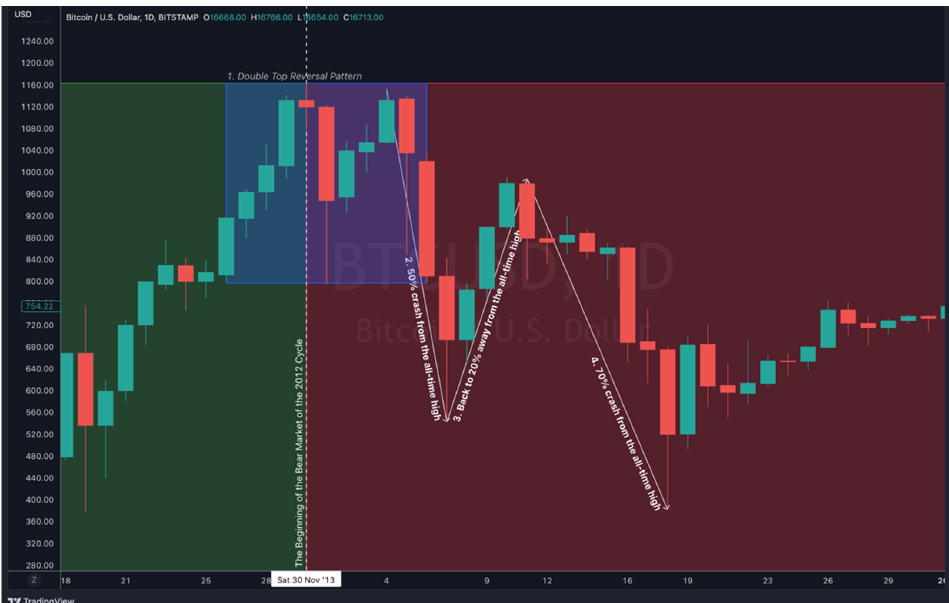
Figure 2. The first 4 sequences of the 2014 bear market during the Bitcoin 2012–2016 halving cycle. The Bitcoin price reached a historical all-time high of $1160. A double top reversal pattern first occurred and indicated a potential reversal, followed by a 50% crash to $550. The Bitcoin price recovered back to 20% away from the historical all-time high ($1000) before making a 70% crash away from the historical all-time high ($340).